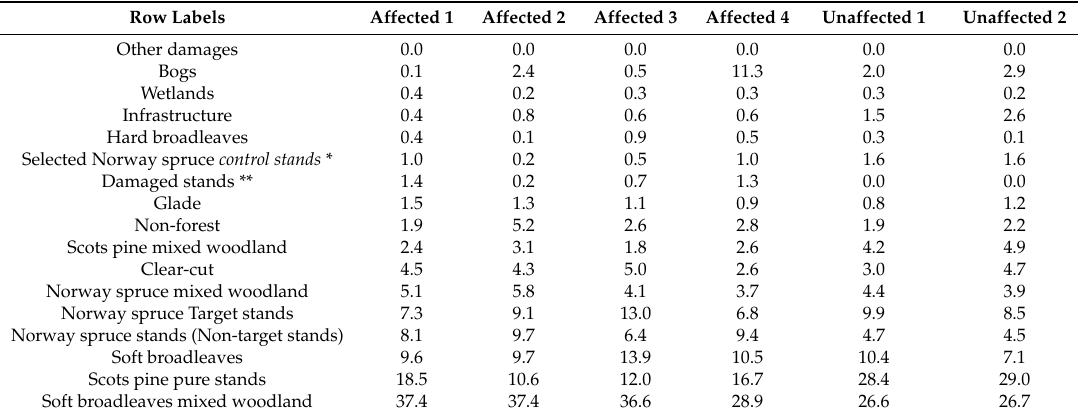
Table 2. Proportions of the forest massif area of the different land cover/use categories. Row